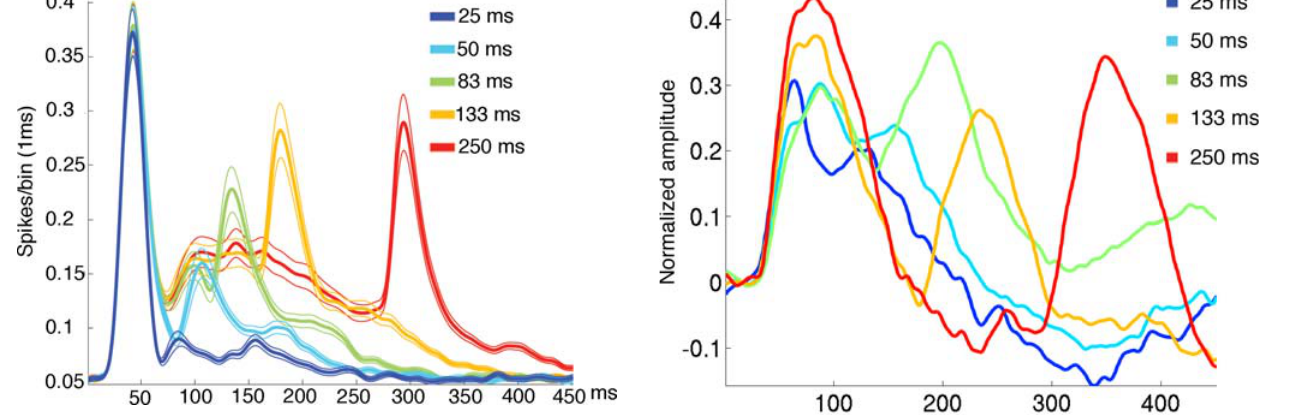
Figure 3. Mean firing rates. The mean firing rates across all animals. Note the significant truncation of 25 ms ON response and the significant dip in the firing rate just prior to the OFF response. The standard errors are shown as thin curves. The mean rate was calculated from all spike trains having statistically significant firing (p , 0.01) to one or more of the stimulus conditions. Note that the dip just prior to the OFF response is reduced at longer stimulus durations and that the amplitude of the OFF response accordingly increases.